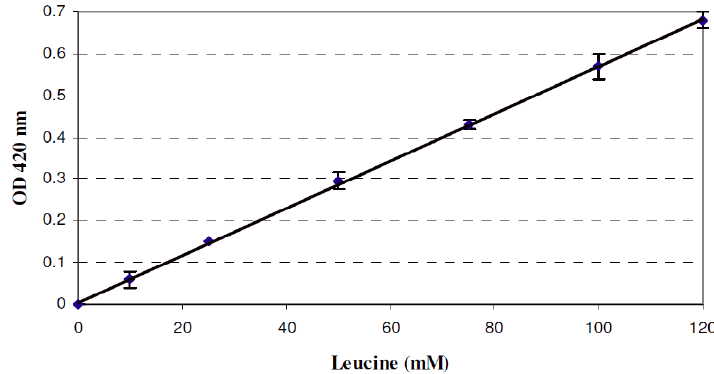
Figure 4. Correlation between OD at 420 nm and leucine concentration determined by the TNBS method.